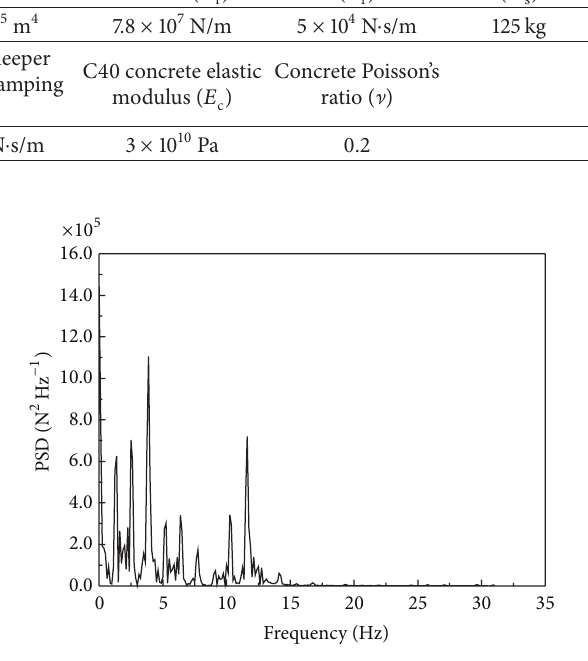
Figure 7: PSD of the load applied on the tunnel shell in the frequency domain.